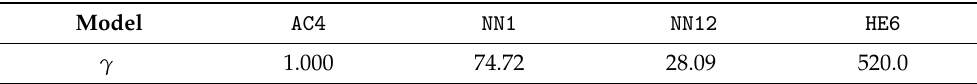
Table 4. Upper bounds γ of the H ∞ norm by static